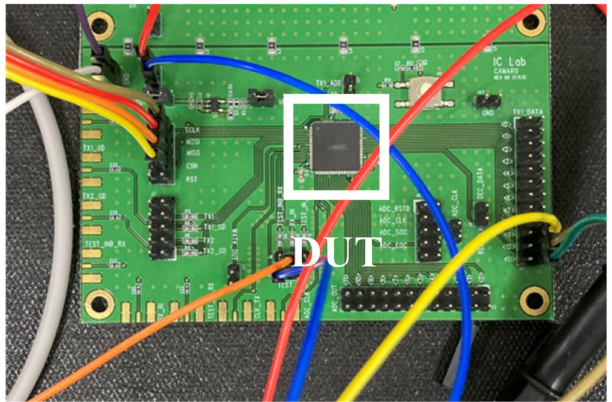
Figure 9. PCB and the device under test of the proposed